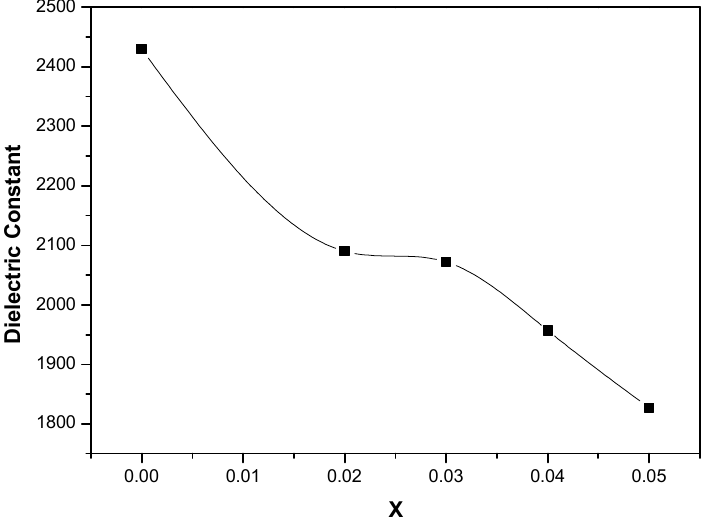
Figure 6. Dielectric constant ( ε r ) of specimens with x.